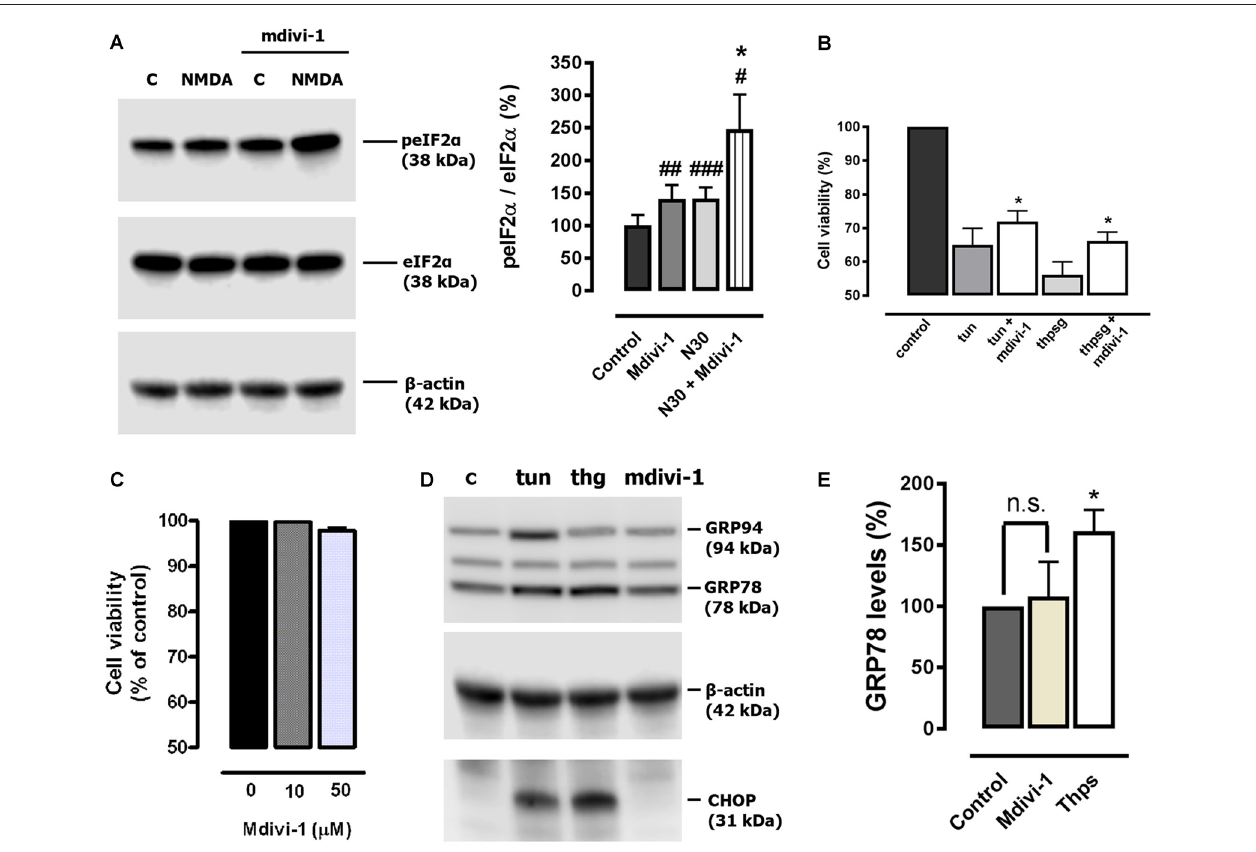
FIGURE 6 | Mdivi-1 enhances the integrated stress response (ISR). (A) Neurons were stimulated with NMDA (30 µ M, 30 min) with or without mdivi-1 (50 µ M) and harvested. For the quantification of eukaryotic initiation factor 2 alpha (eIF2 α ) phosphorylation, peIF2 α signal was measured and normalized to total eIF2 α